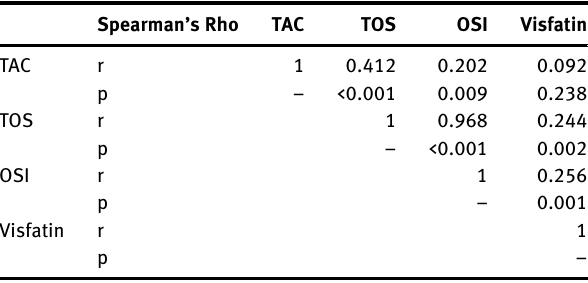
Table  : The correlations of the laboratory parameters (visfatin, TAC, TOS, and OSI) with each